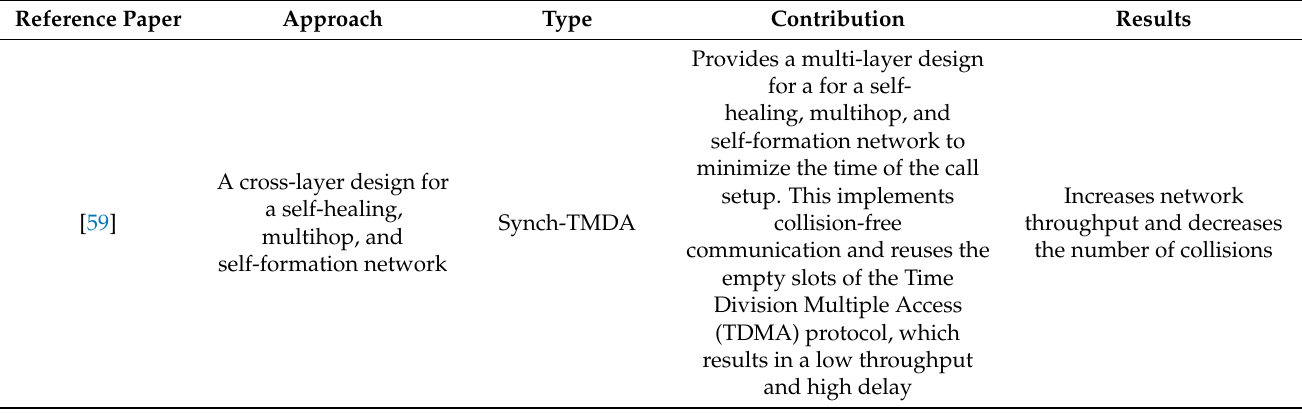
Table 6. Machine learning-based